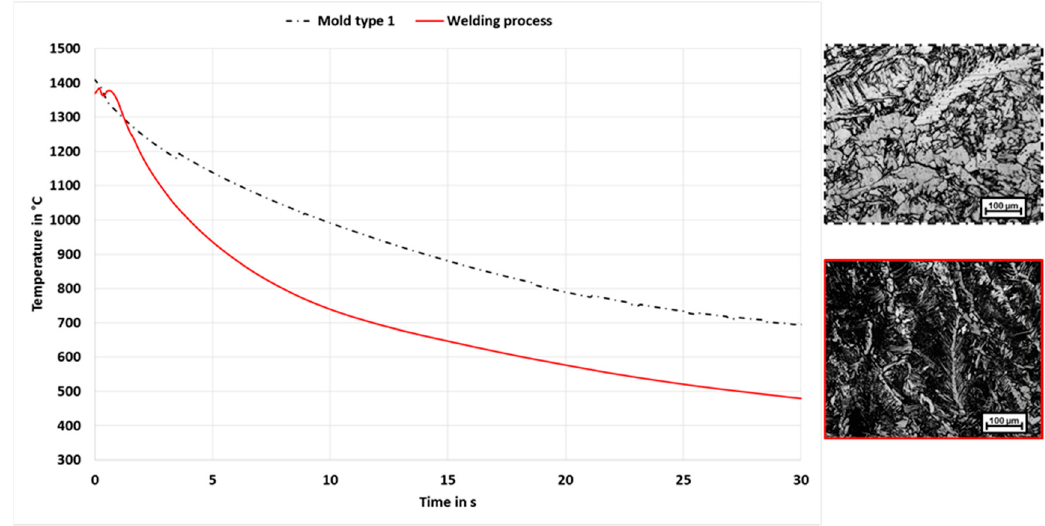
Figure 12. Comparison of cooling behavior and microstructure of the welding and casting process with casting mold 1.